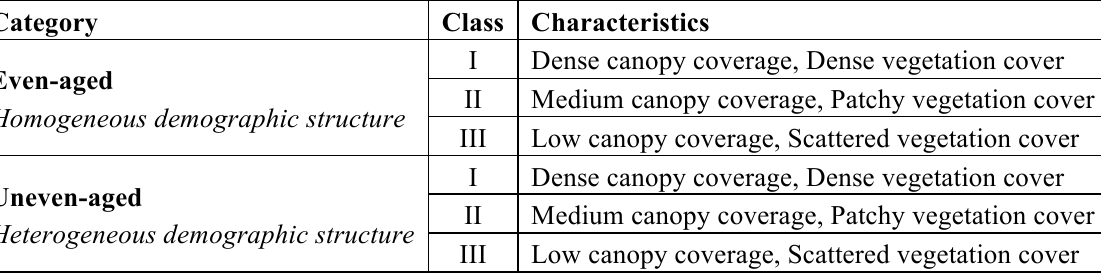
Table 2. Characteristics of the stand structure